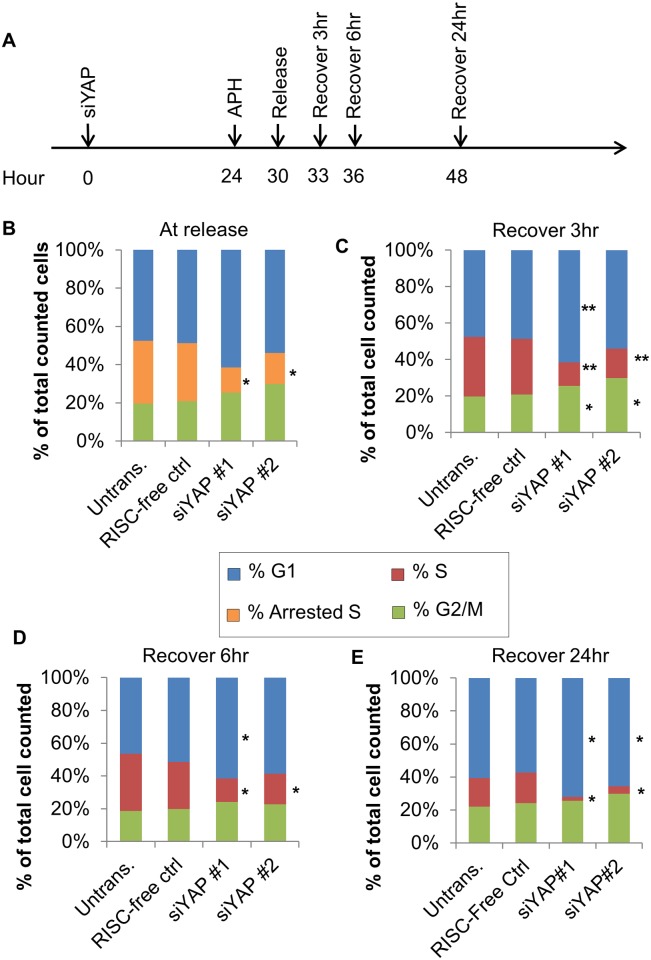
Yap is not required for S-phase progression in HUVECs.A. Schematic of the APH experiment. HUVECs were treated with siRNA for 24 hours then incubated with 5µM APH for 6 h. HUVECs were collected at 3, 6, or 24 h post-APH removal, receiving a pulse of BrdU at the time of harvest. B. Quantification of cell cycle profiles comparing control and YAP-KD cells after 6 h APH arrest (“Release”). All HUVECs exhibited S-phase stall upon APH treatment (orange bars). Significantly fewer S-phase cells were detected in siYAP-treated HUVECs. p-values were calculated by comparing each phase to the corresponding datasets from RISC-free control. *, p < 0.04. C. Quantification of cell cycle profiles comparing control and YAP-KD cells 3 hours after APH removal. All HUVECs, including siYAP-transfected cells, reinitiated S-phase with similar kinetics. p-values were calculated as described in (B). *, p < 0.04; **, p < 0.007. D. Quantification of cell cycle profiles comparing control and YAP-KD cells 6 h after APH removal. HUVECs with siYAP transfection could restart stalled S-phase in a YAP-independent manner. p-values were calculated as described in (B). *, p < 0.04. E. Quantification of cell cycle profiles comparing control and YAP-KD cells 24 h after APH removal. Normal cell cycle profiles were re-established in control cells while the YAP-KD cells had fewer S-phase cells, suggesting that S-phase progression is YAP independent. p-values were calculated as described in (B). *, p < 0.007. See also S5 Fig.